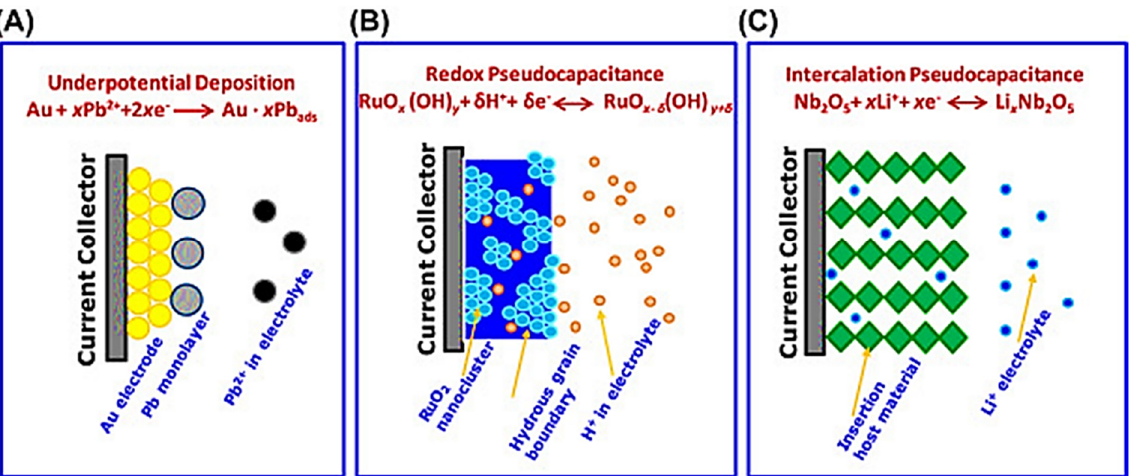
Figure 6. Scheme of the three common types of pseudo-capacitive electrodes, underpotential deposition ( A ), redox pseudo-capacitance ( B ), and intercalation pseudo-capacitance, ( C ) “Reproduced with permission from [44], Elsevier, 2020”.